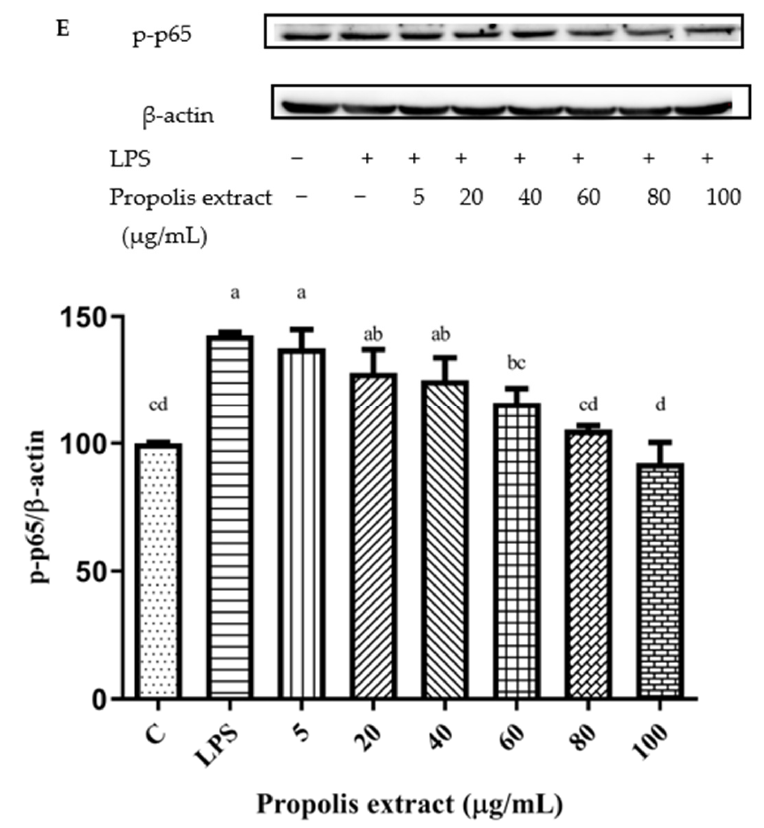
Figure 11. Activation of NF- κ B signaling pathway induced by individual flavonoids (chrysin, pinocembrin, galangin, and pinobanksin) and propolis extract in 10 µ g/mL LPS-induced H9c2 cells. H9c2 cells were stimulated with different concentrations of phytochemicals (chrysin, pinocembrin, galangin, pinobanksin, and propolis extract) for 12 h and then treated with 10 µ g/mL LPS for 12 h; finally, the activation of the NF- κ B signaling pathway was detected via Western blot. ( A ) Activation of NF- κ B signaling pathway in chrysin-induced H9c2 cells. ( B ) Activation of NF- κ B signaling pathway in pinocembrin-induced H9c2 cells. ( C ) Activation of NF- κ B signaling pathway in galangin-induced H9c2 cells. ( D ) Activation of NF- κ B signaling pathway in pinobanksin-induced H9c2 cells. ( E ) Activation of NF- κ B signaling pathway in propolis-extract-induced H9c2 cells. Values are expressed as the mean ± SEM ( n = 3). Values with different letters (a, b, c, d, e, f) in the figure showed significant differences at p < 0.05.